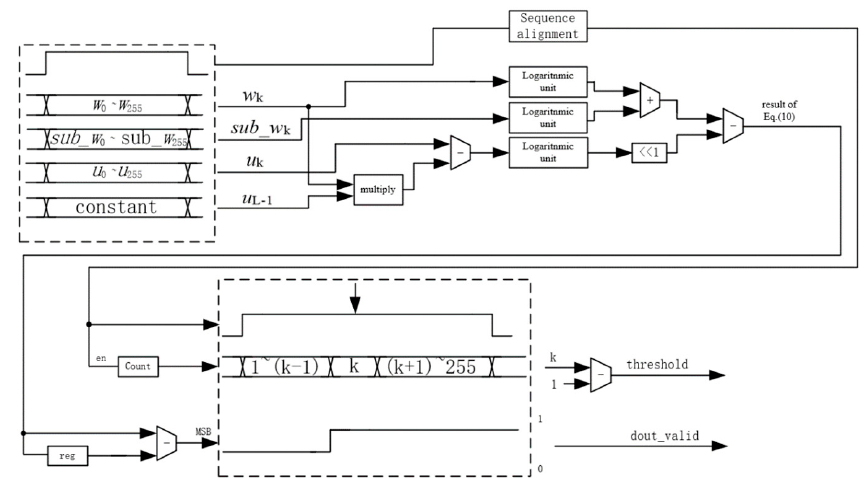
Figure 15. Architecture of threshold calculation.